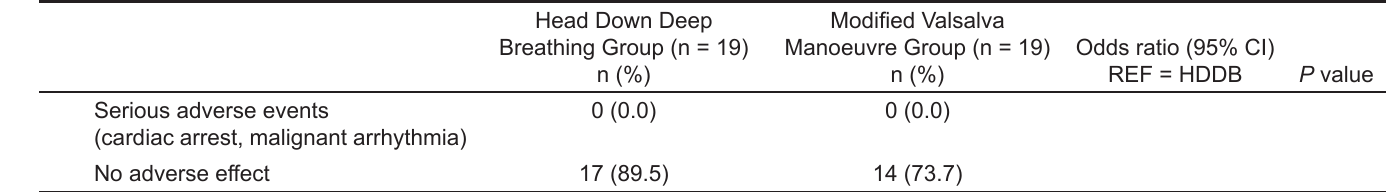
Table 3. Treatment methods used and the success rates when study interventions failed.